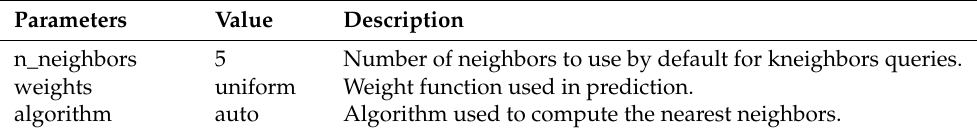
Table 14. kNN parameters from scikit-learn library.